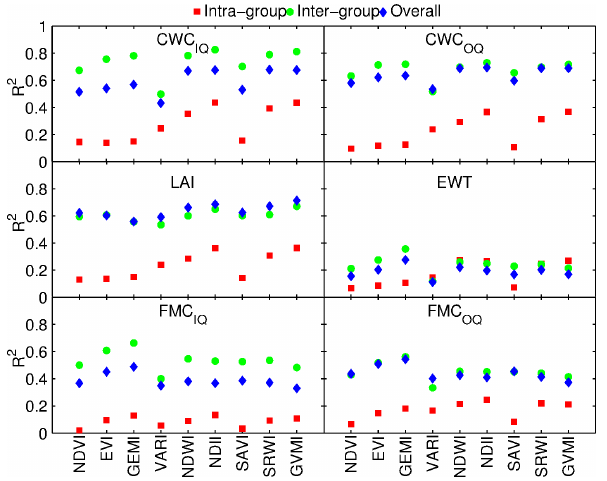
Figure 5. Determination coefficient for proximal (green circles) and MODIS (red squares) empirical models after bootstrap. Upper and lower limits of the confidence intervals for MODIS and proximal sensing are